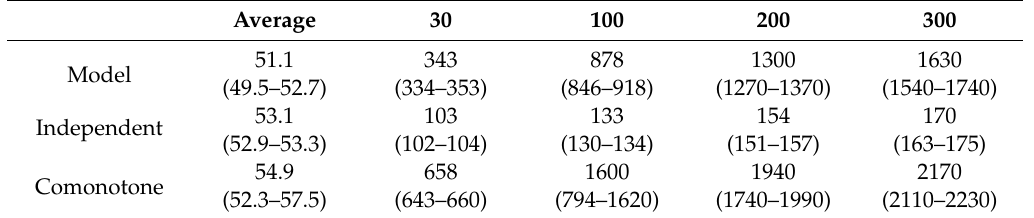
Table 4. Average yearly damage and estimated damage (in mio. € ) for floods with return periods of 30, 100, 200, and 300 years, for the municipalities with claim data. The damage is calculated with the HORA model and with three di ff erent dependence structures between the municipalities (the estimated dependence structure of this paper, independence, and comonotone dependence). Numbers in parentheses are the 95% confidence intervals from the Monte Carlo